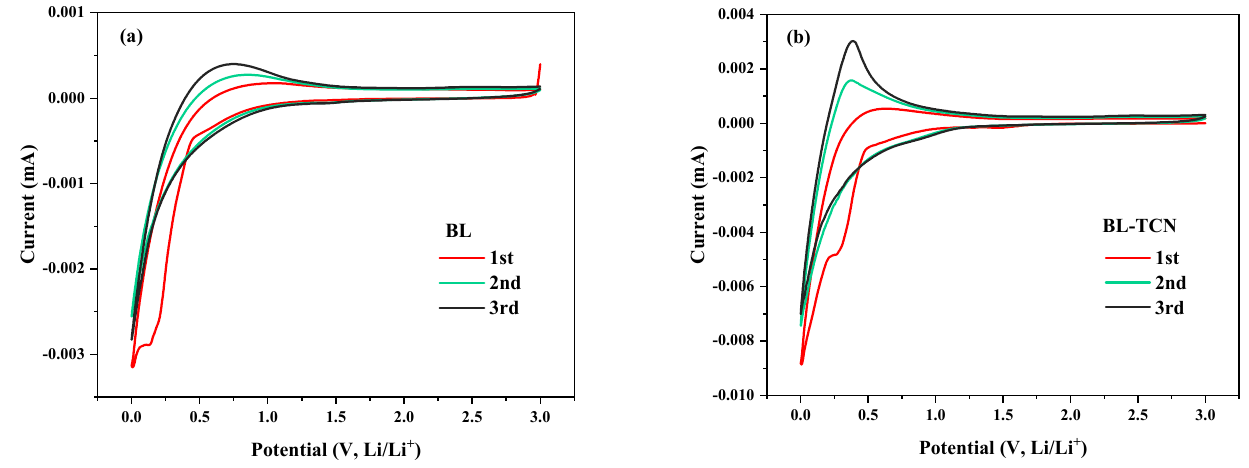
Figure 2. CV curves of Li/SiO@C half-cells at a scan rate of 0.001 V/s: ( a ) BL; ( b ) BL-TCN. XPS was used to analyze the anode surfaces after cycling in various electrolytes, resulting in the O 1s and Li 1s spectra shown in Figure 3. For the XPS spectra of O 1s, there were three apparent peaks in the BL and BL-TCN groups, among which the peak near 531.18 eV was C=O, and the peak near 532.18 eV was C–O. Notably, the Li 2 CO 3 peak on the anode of the battery sample with the BL-TCN electrolyte after cycling was greater than that of the battery sample with the BL electrolyte, which proved that the